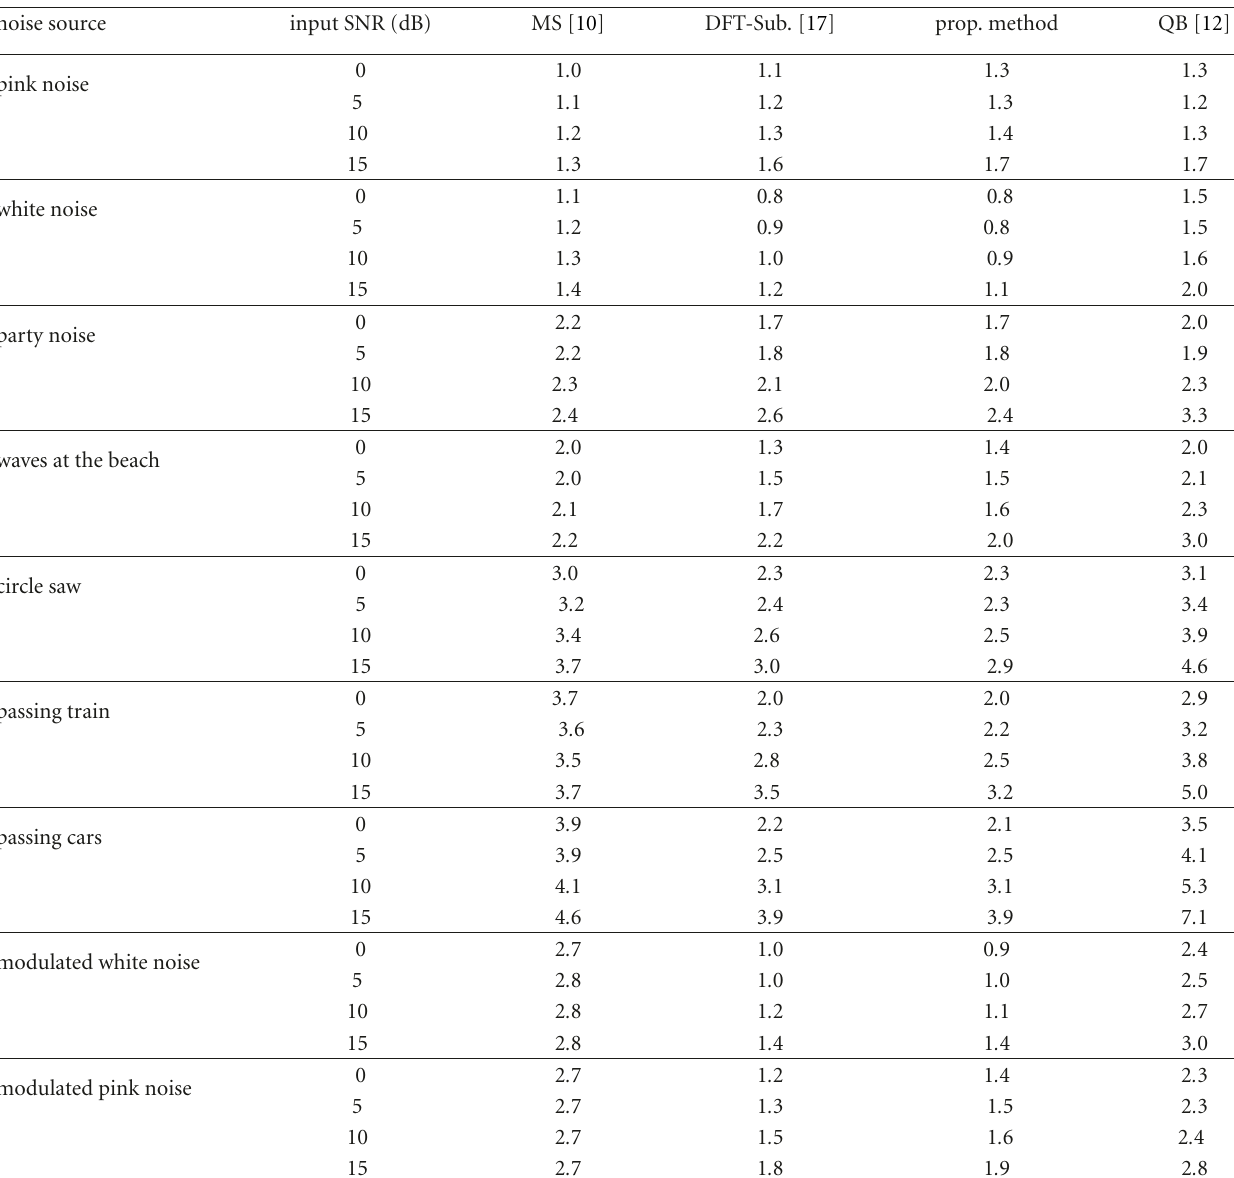
Table 2: Performance in terms of LogErr